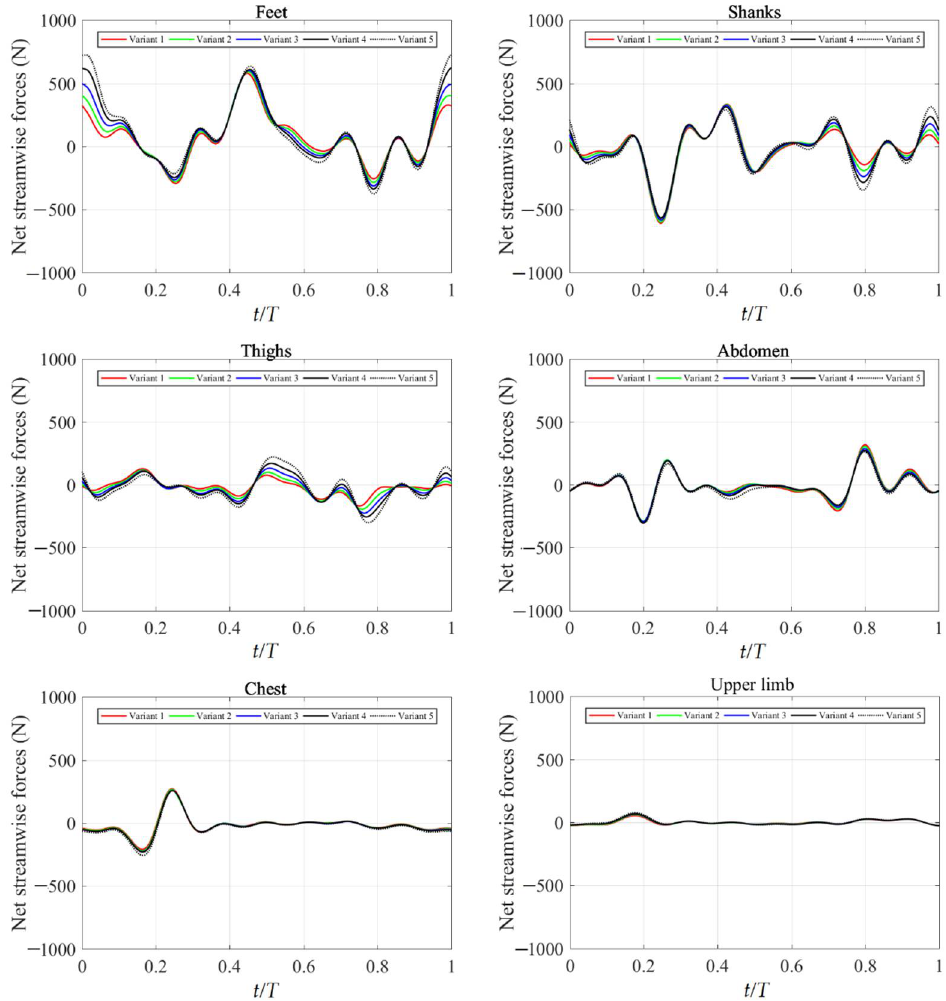
Figure 6. Net streamwise forces of swimmer’s limbs in a cycle under different trunk oscillations.